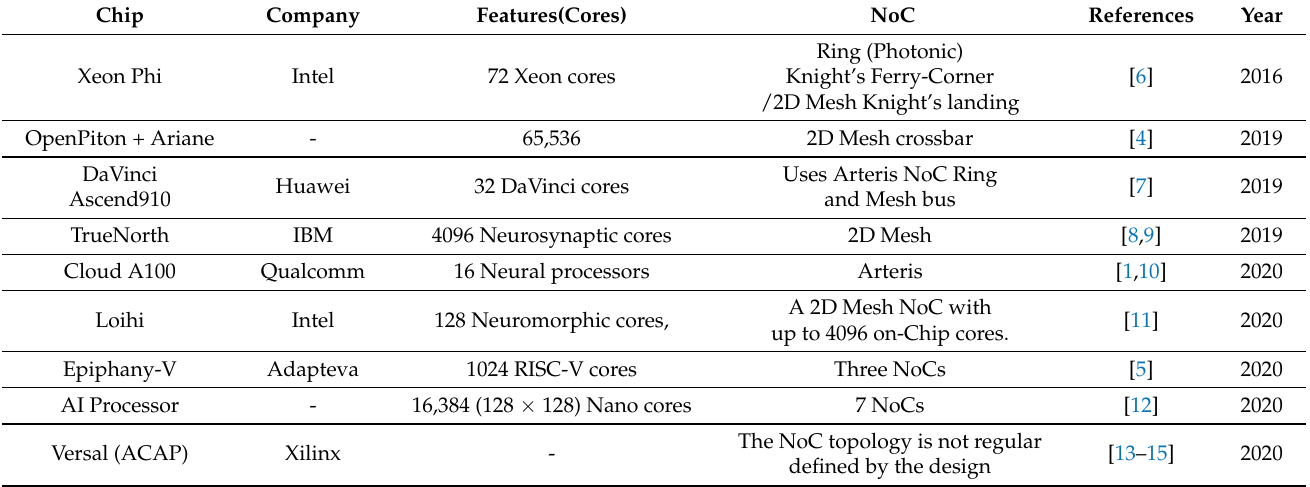
Table 2. Recent chips by relevant companies. We describe the type of cores and the on-Chip interconnection. All designs have a Many-Core